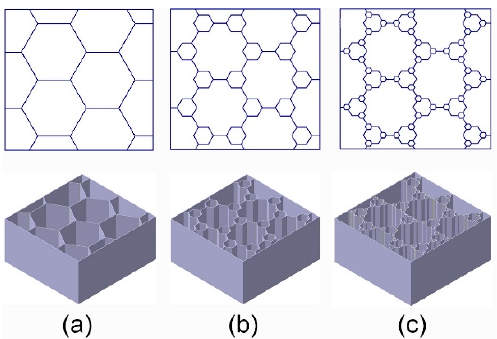
Figure 6. Three types of bionic structures with different filling methods of honeycombs: ( a ) BHS, original honeycombs; ( b ) BHS-1, filling mode with first-order; ( c ) BHS-2, filling mode with second- order.